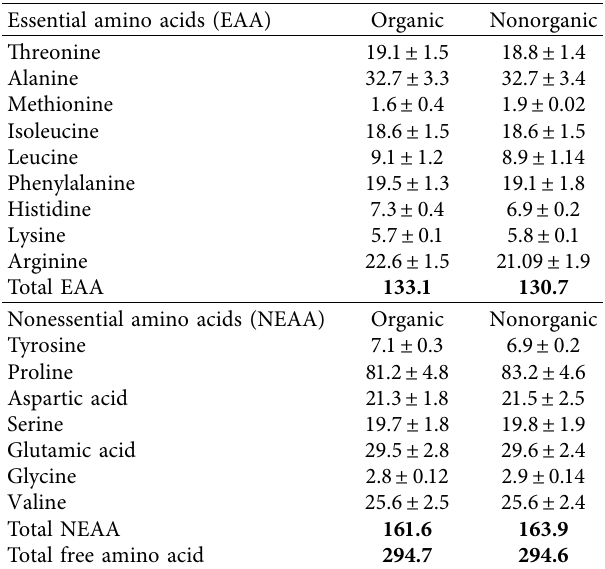
Figure 4: Total phenolic content of both organic and nonorganic vegetable soups at 0 h, 24h, 48h, 72h, and 96h. Each data point is the mean of triplicated data with ± SE. The bars represented with different letters are significantly different from each other at p � 0 . 05 as evaluated by DMRT. Table 2: Analysis of free amino acid composition of both organic and nonorganic vegetable